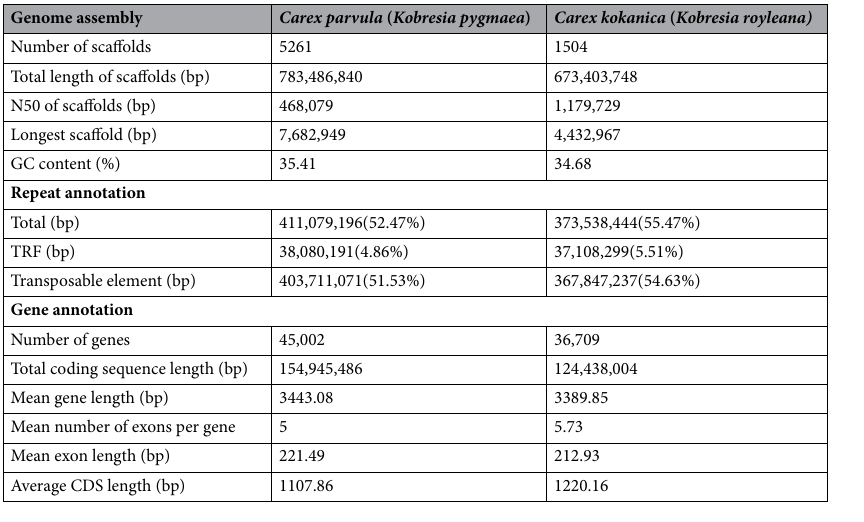
Table 1. Statistics of assembled Carex parvula and Carex kokanica assembly and